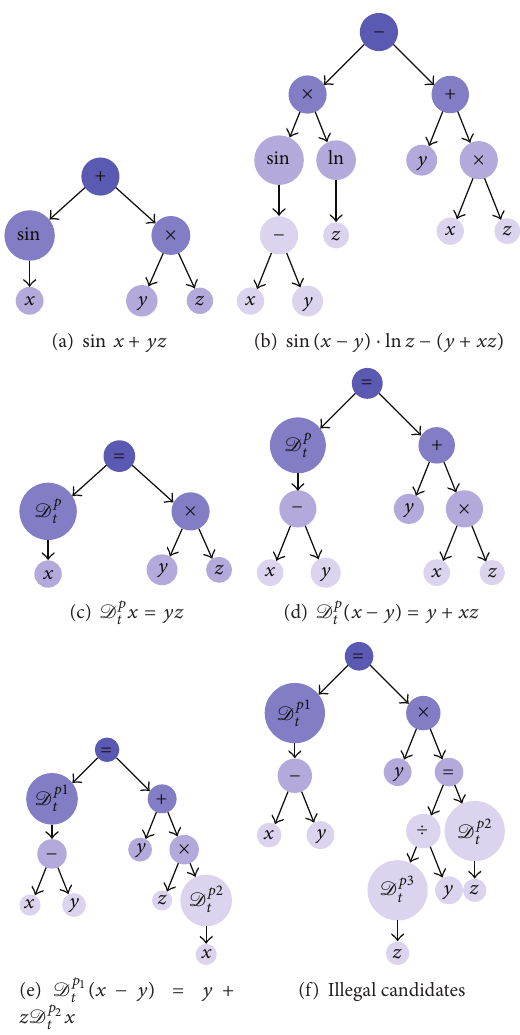
Figure 2: Some examples of the tree structures in GP